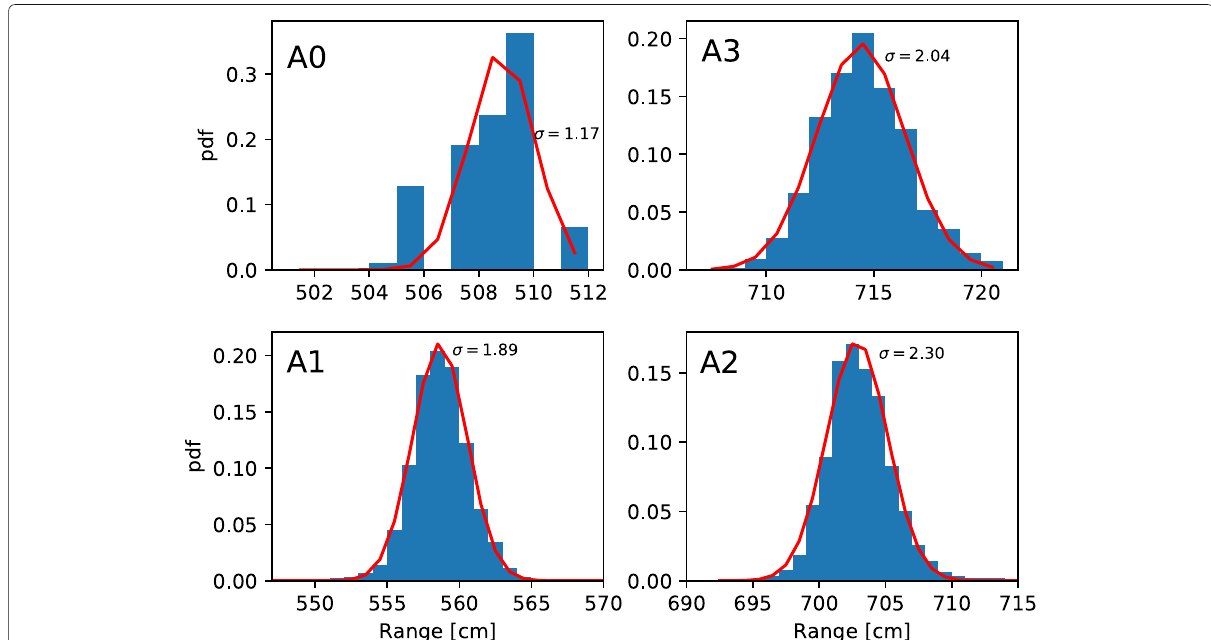
Fig. 3 Graphical representation of measurement probability distributions for all four anchor nodes (A0 to A3). The origin of track position is the closest point to A0